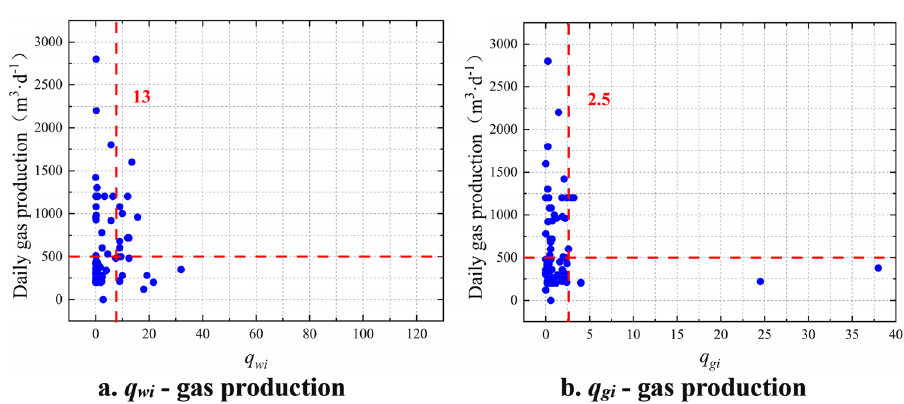
Figure 4. Determination of critical values of evaluation parameters for the effective supporting length of proppant in